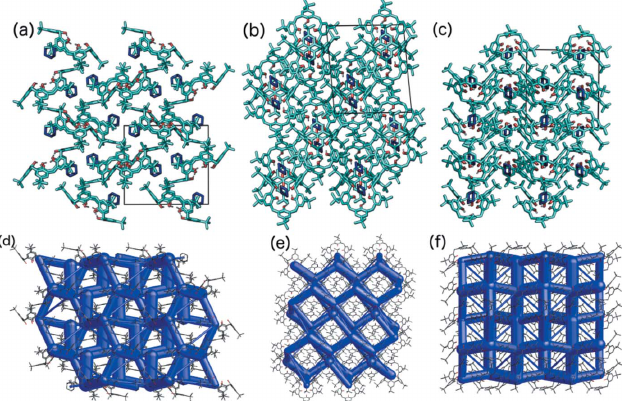
Figure 7 ( a )–( c ) The crystal packing and ( d )–( f ) the crystal framework of 4 : ( a ), ( d ) viewed along the [100] axis, ( b ), ( e ) viewed along the [010] axis, and ( c ), ( f ) viewed along the [001] axis. Note that this structure is isostructural with structures 5 – 8 .